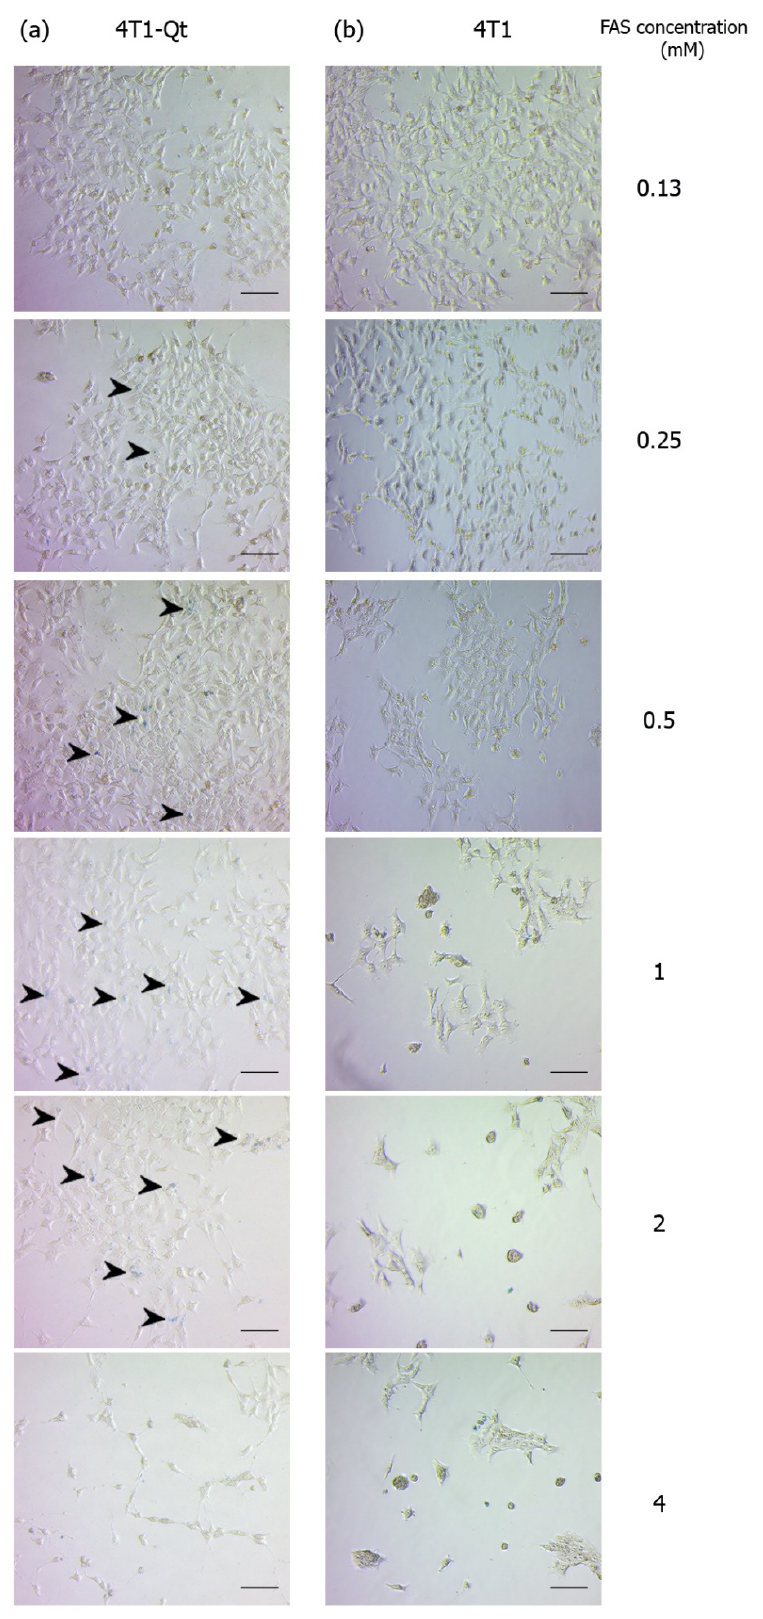
Figure 4. Prussian blue staining of 4T1-Qt ( a ) and 4T1 ( b ) cells after 24 h incubation with 0.13–4 mM FAS. Bright-field microscopy, scale bar 50 µm. Black arrows indicate iron deposits in 4T1-Qt cells.